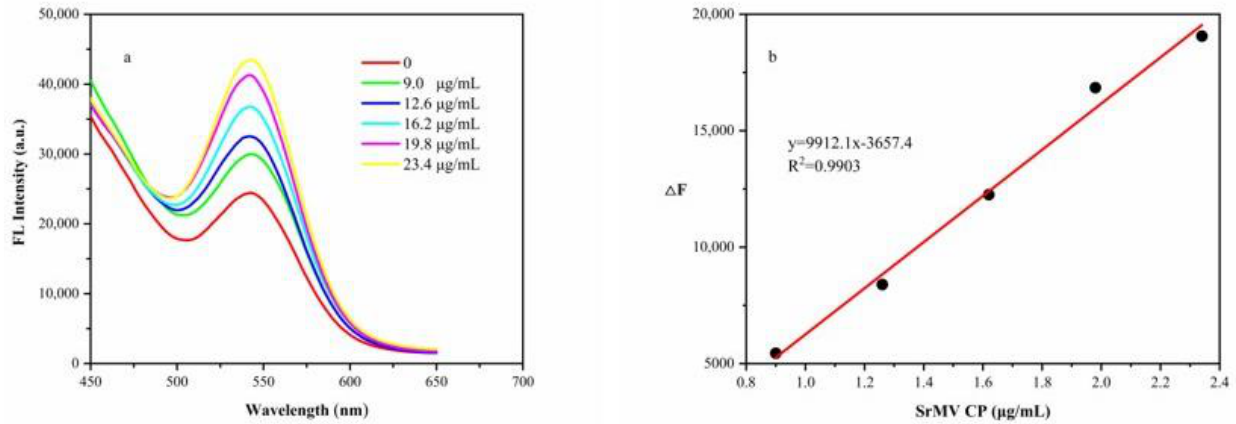
Figure 6. ( a ) The effect of CP concentrations on the fluorescent intensity of the developed biosensor